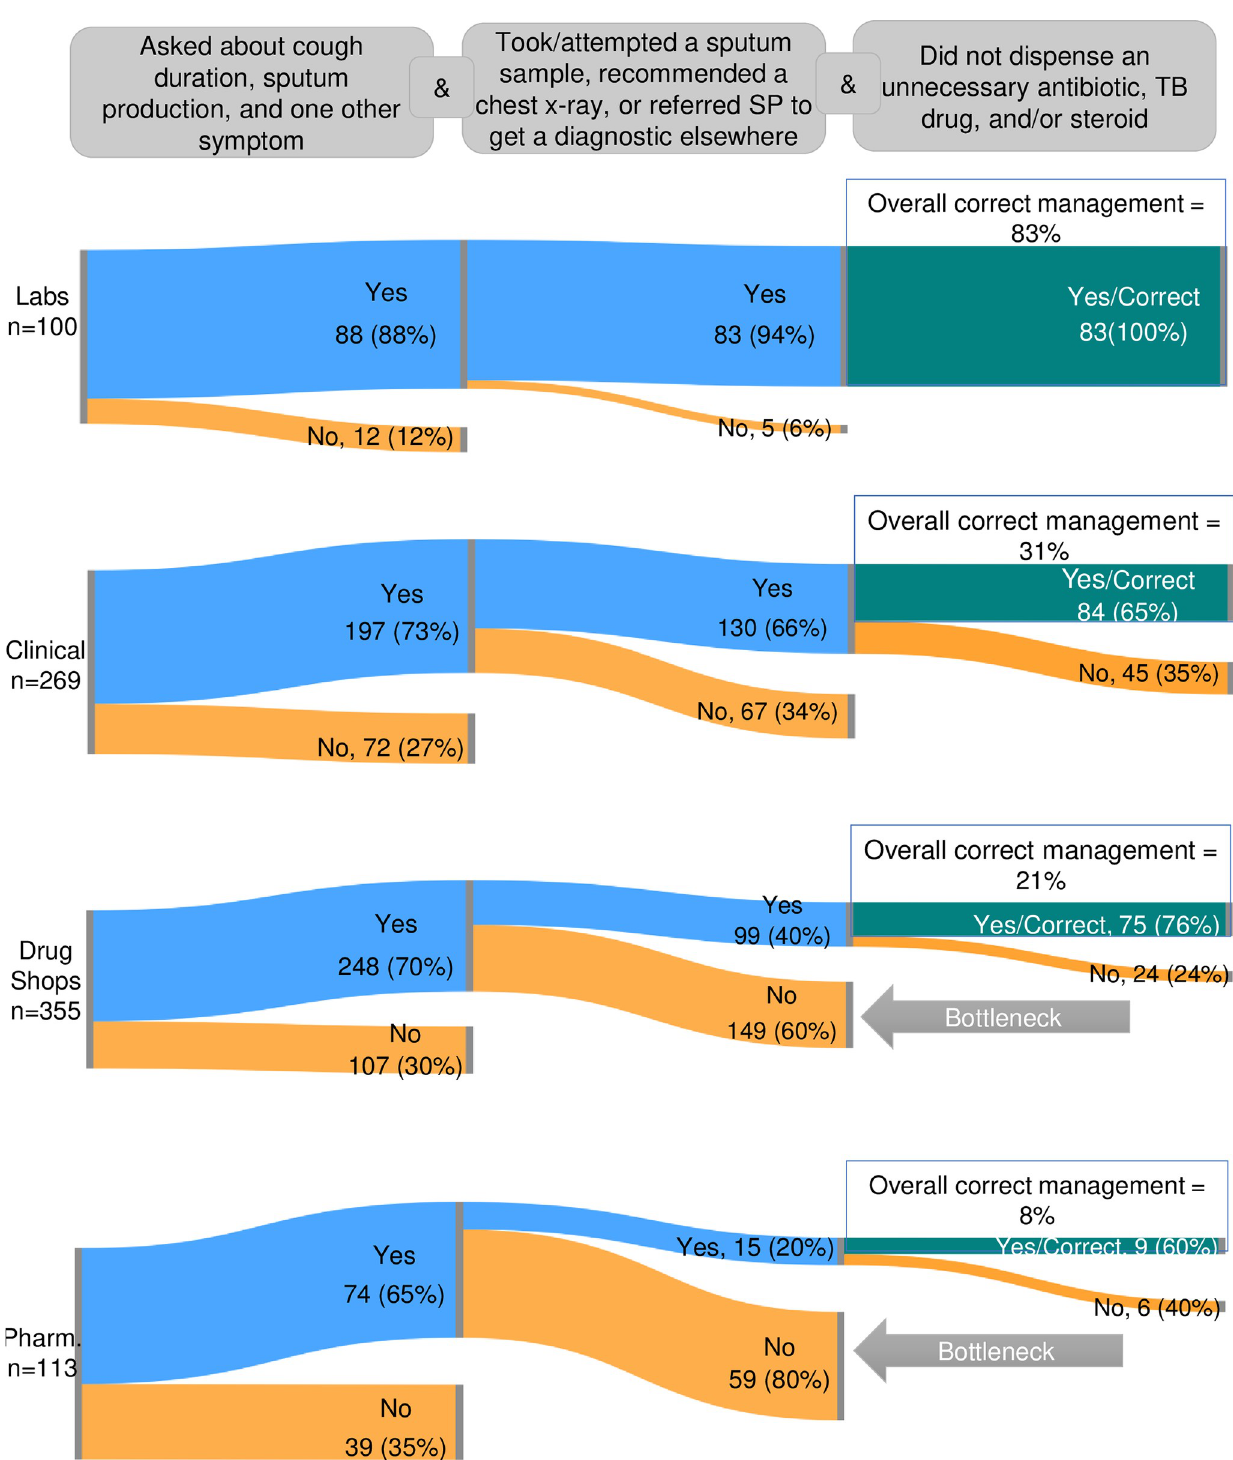
Fig 3. Case 1: Private sector bottleneck analysis, by cadre. The diagrams above show the expected combination of correct management actions for Case 1 for each of the private sector cadres included in this study. The orange bars depict the relative proportion of providers who exited the correct management flow at each case element. The green bars show the proportion of providers who demonstrated all three case management actions during their interaction with the SP.